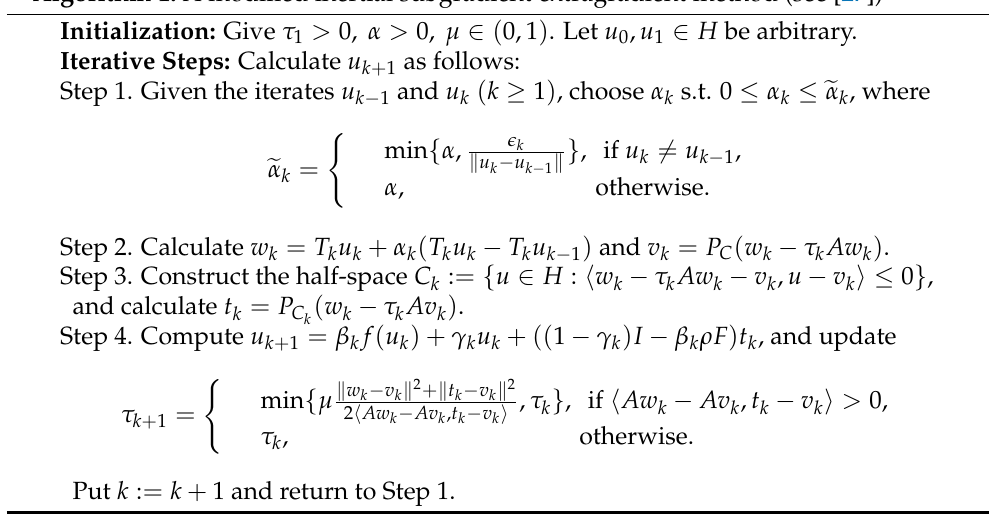
Algorithm 1: A modified inertial subgradient extragradient method (see